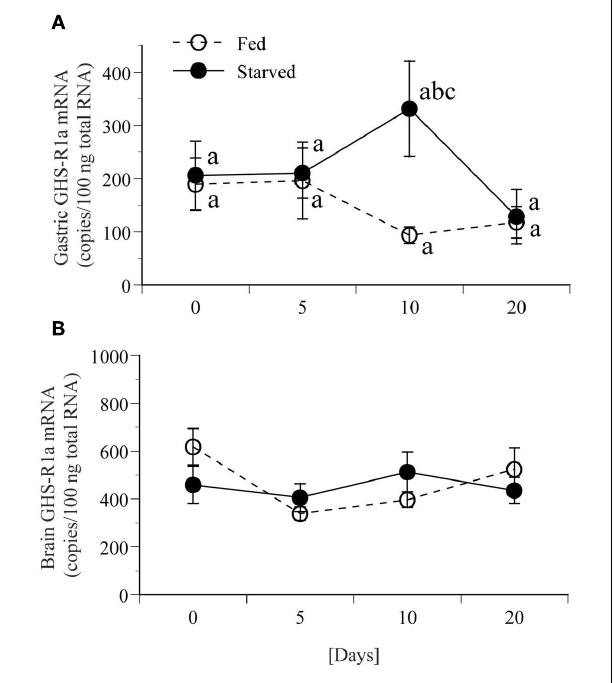
FIGURE 8 | Changes in GHS-R1a mRNA expression in stomach and brain of bullfrog for 20days food deprivation. mRNA expression levels were quantified by real-time PCR in stomach (A) or brain (B) with duplicate measurements.White and black circles indicate the result for fed and fasted frogs, respectively.Values are the means ± SEM ( n = 8). Statistical analysis (non-repeated ANOVA followed by Bonferroni/Dunn test) was conducted. Different letters indicate statistical differences ( P < 0.05): b, 10-days fed group vs. 10-days fasted group; c, 20-days fed group vs. 10-days fasted